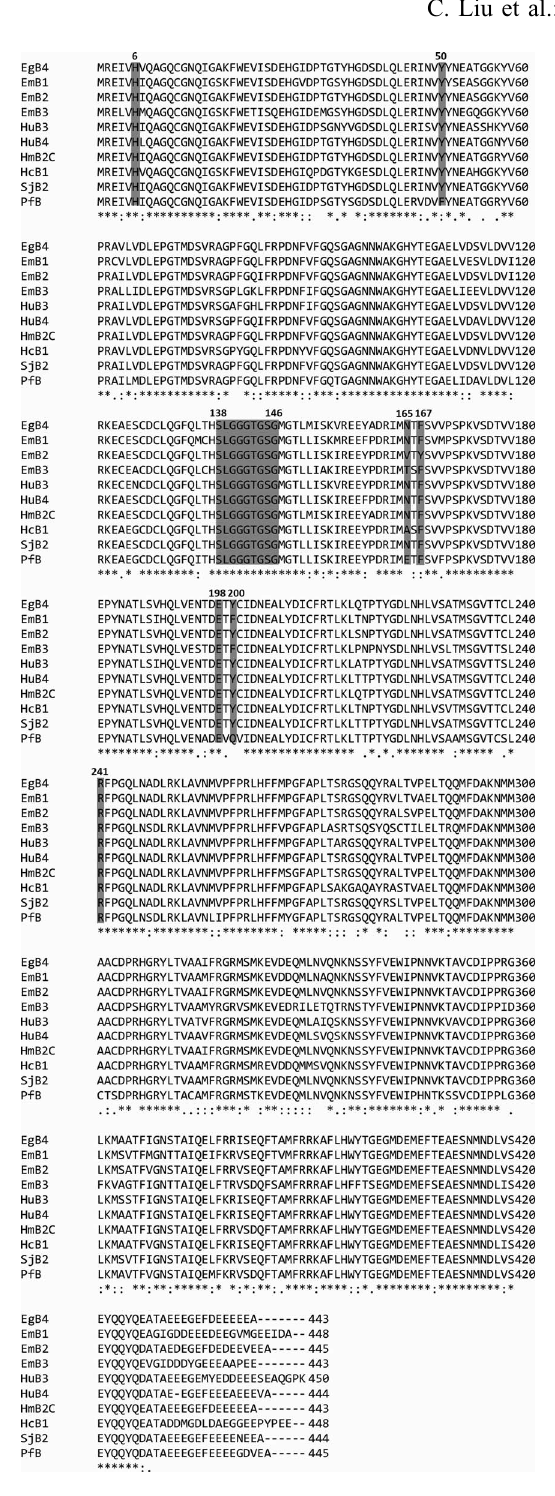
Figure 3. The sequence alignment of Echinococcus granulosus b 4 -tubulin and corresponding sequences from humans and parasites. Symbol meanings are as in Figure 2. EgB4, E. granulosus b 4 -tubulin; EmB1, E. multilocularis Tub-1 gene (7838198); EmB2, E. multi- locularis Tub-2 gene (7838200); EmB3, E. multilocularis Tub-3 gene (7838202); HuB3, human B3 (50592996); HuB4, human B4a (574584803); HmB2C, H. microstoma beta 2C (674589300); HcB1, H. contortus beta tubulin isotype 1 (124244617); SjB2, S. japonicum beta 2 (226467271); PfB, P. falciparum beta